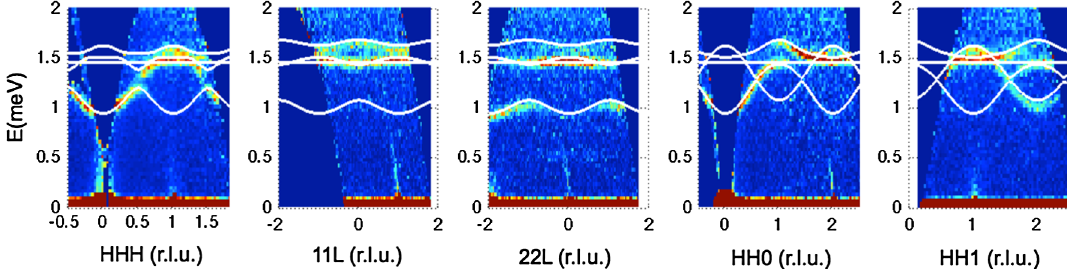
FIG. 4. Dispersions (white curves) obtained from the fitting procedure over-plotted on the data at H ¼ 5 T